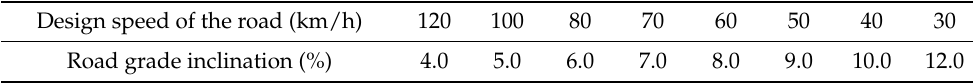
Table 4. The maximum road gradient depending on the adopted design speed [45]. Design speed of the road (km/h)